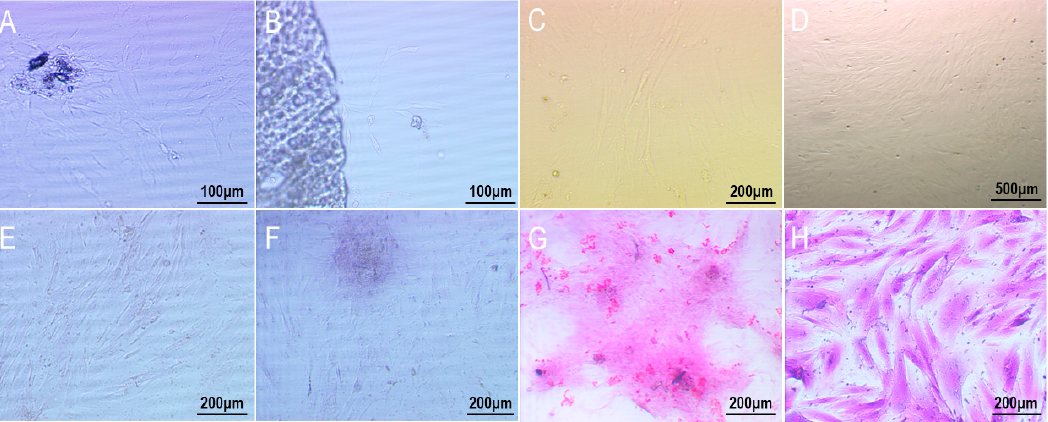
Figure 6. Staining observation and microscope photographs of osteoblasts’ primary culture and con- tinuous culture. ( A , B ) Primary osteoblasts on the 2nd and 5th day, respectively; ( C , D ) P4 osteoblasts on the 2nd and 4th day, respectively; ( E , F ) ALP staining; ( G ) Alizarin red staining; ( H ) H&E staining. Osteoblasts were stained with H&E to observe the cell morphology more